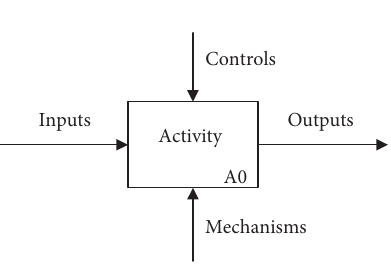
Figure 2: Basic structure of